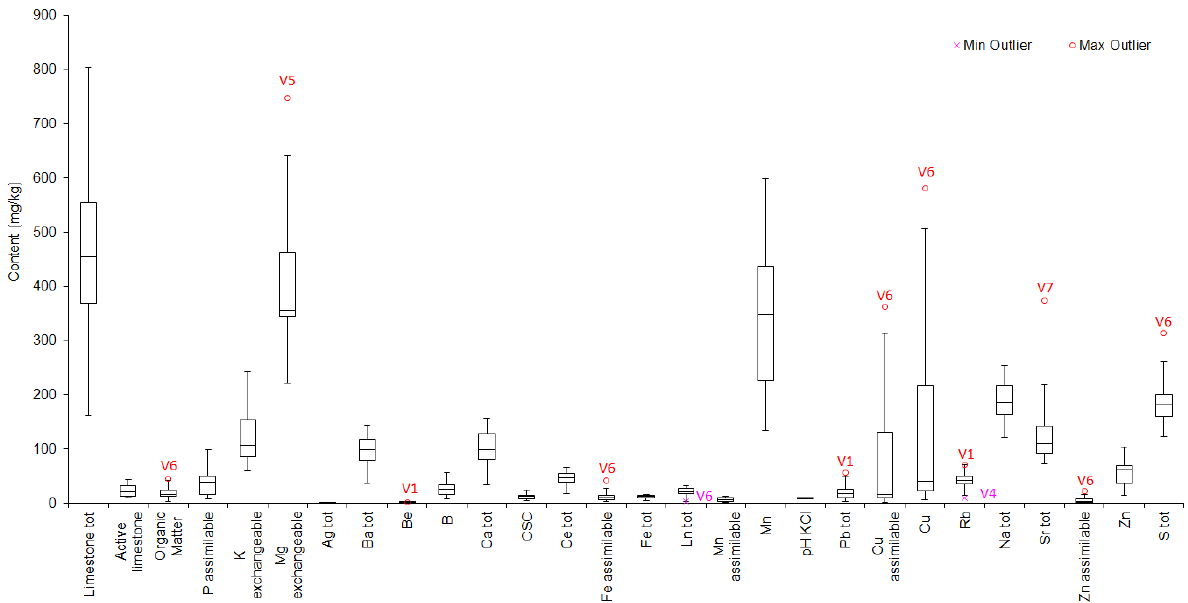
Figure 8. Boxplot of soils’ elemental mineral composition. Measured statistical indices: The middle bar in the box represents the median. The circles and cross symbols represent respectively the maximum and minimum statistical outliers. Beside the outlier symbol is the vineyard label. Data are presented in the Supplementary Material (see Table S1).